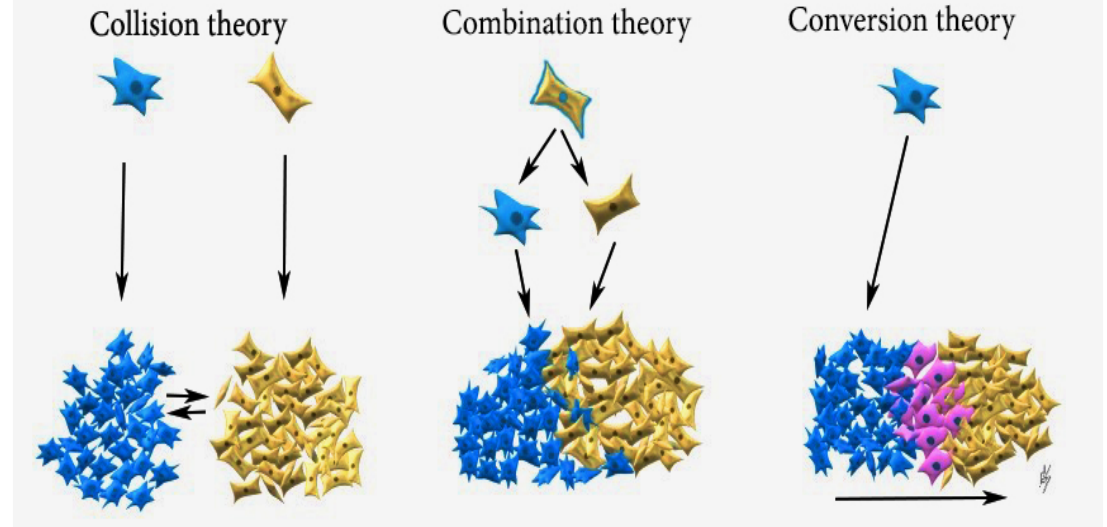
Figure 7. Collision theory: Carcinoma (blue cells) and sarcoma (brown cells) are two independent neoplasms, which later merge; Combination theory: both components are derived from a single stem cell that undergoes divergent differentiation early in the evolution of the tumour; Conversion theory: the sarcomatous element is derived from the carcinoma during tumour evolution (pink cells — epithelial–mesenchymal transition).